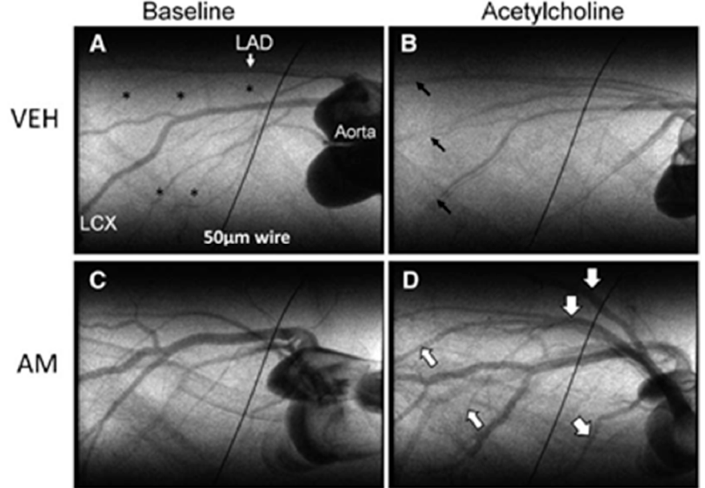
Figure 5. SXR-based coronary angiography of rat hear. The images were acquired 72 h after ischemia-reperfusion injury. ( A , C ) represent single-frame images of iodine contrast during baseline condition and ( B , D ) during acetylcholine infusion. Reprinted with permission from [4].